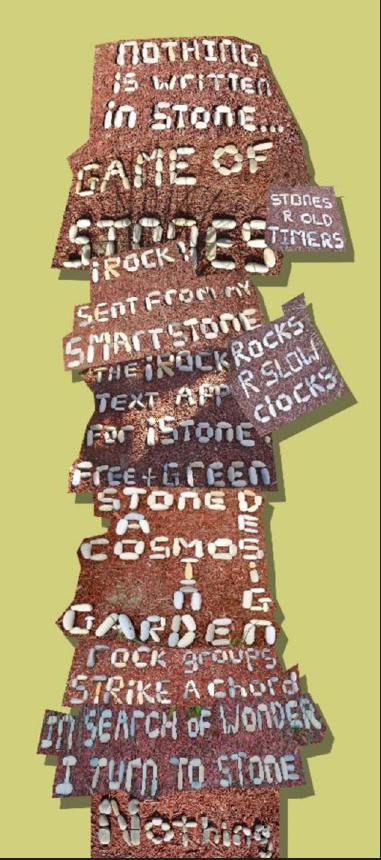
Figure 3: Richard Turner and Paul Harris, “Petriverse Text Messages.” Photo: Richard Turner and Paul